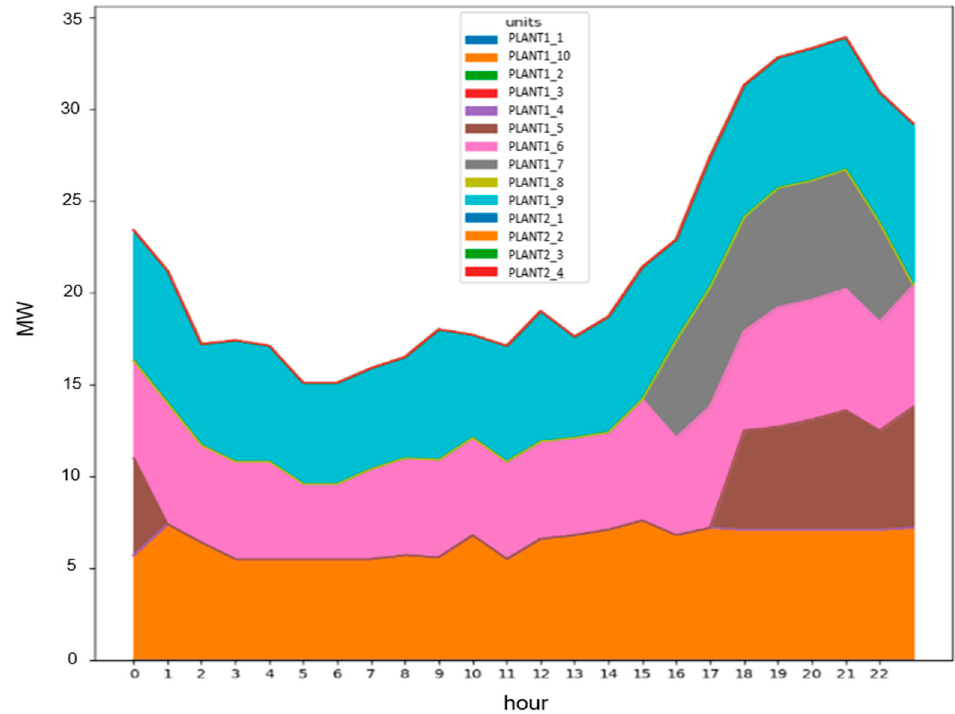
Figure 5. Case 1 hourly power generation of each fuel generator.